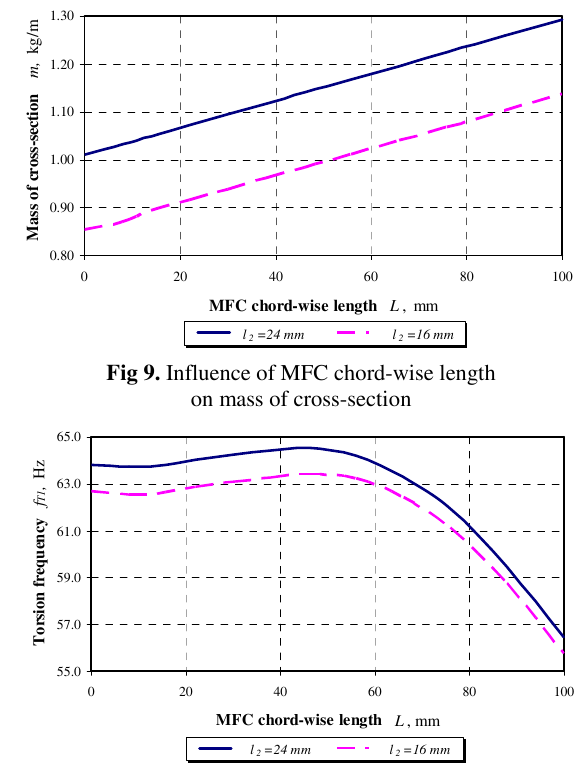
Fig 10. Influence of MFC chord-wise length on torsion